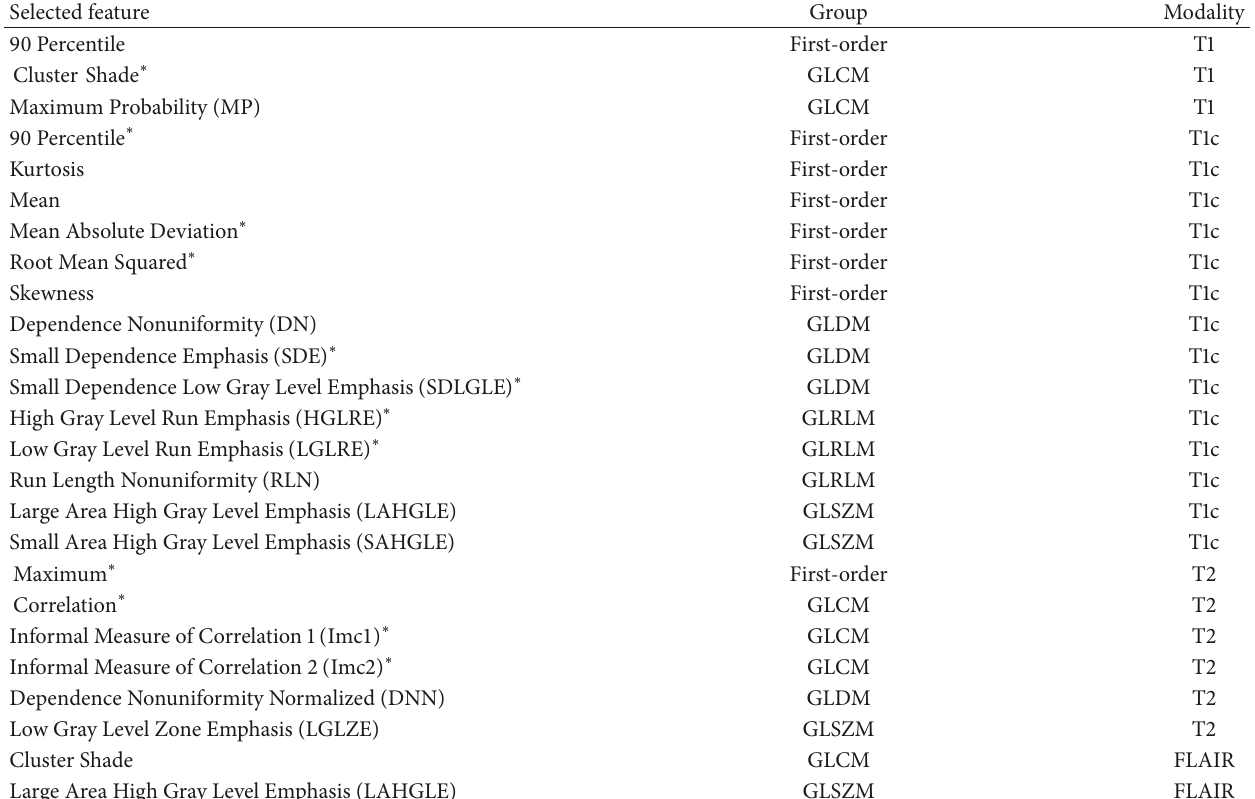
Table 5: The feature subset based on ground truth